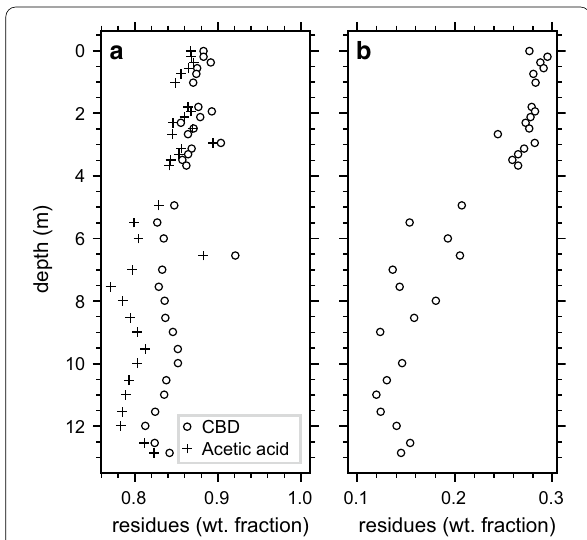
Fig. 2 a Depth variation of VGP latitude. b Interpreted polarity. Black represents normal polarity, white represents reversed polarity, and gray represents an interval of uncertain polarity (see text for discussion)